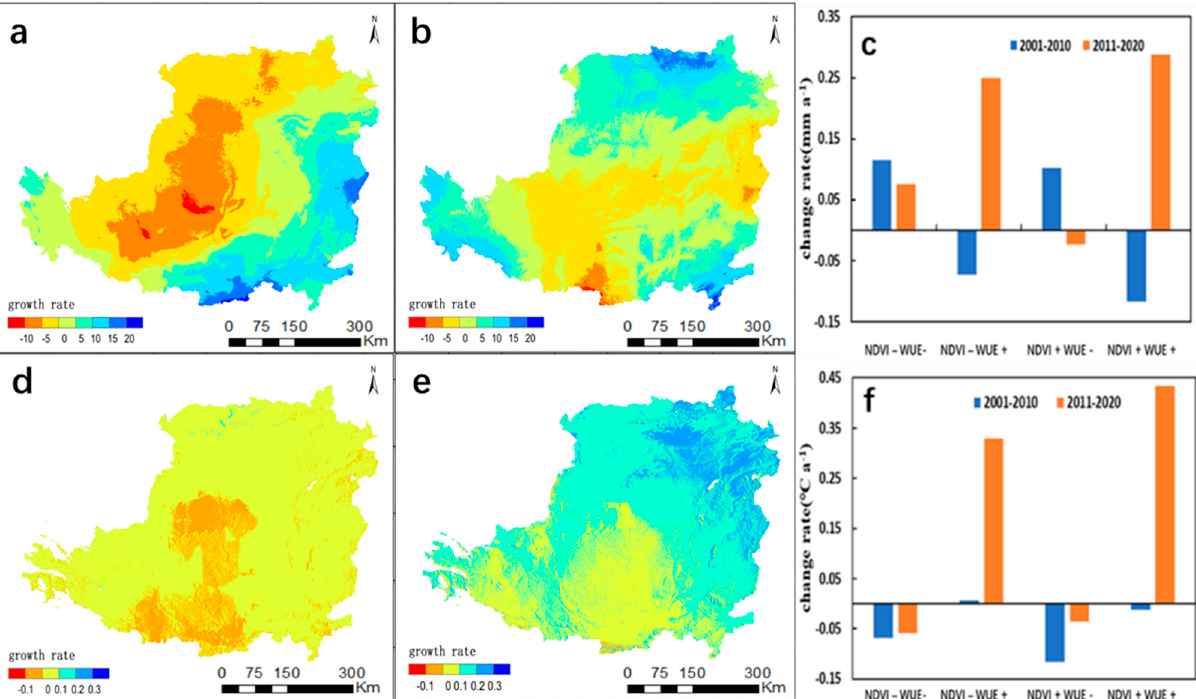
Figure 7. ( a ) Variation trend of precipitation on the Loess Plateau from 2001 to 2010. ( b ) Variation of precipitation on the Loess Plateau from 2011 to 2020. ( c ) Statistical graph of precipitation on the Loess Plateau. ( d ) Variation of temperature on the Loess Plateau from 2001 to 2010. ( e ) Trend map of temperature changes in the plateau from 2011 to 2020. ( f ) Statistical map of temperature changes in the Loess Plateau.